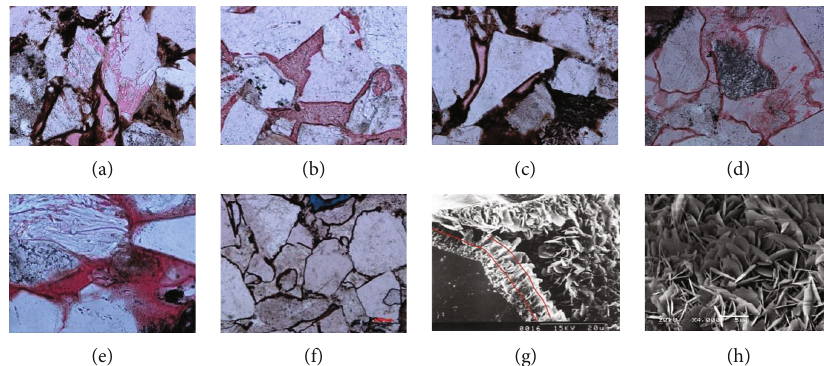
Figure 7: Micrograph of reservoir rock. (a) Shan138 well 2156.13m Chang 6 3 . The chlorite clay fi lm is composed of inner layer and outer layer. The outer crystal structure is complete, and the inner layer is denser (SEM observations × 1000). (b) Gao42 well 1759.56m Chang 6 3 coniferous autochlorite crystals on clay fi lm surfaces (SEM observations × 2000). (c) Shan139 well 2211.91m Chang 6 3 . The chlorite clay fi lm develops and is absent at the contact point of granule (injecting thin sections observations × 200). (c) Bai246 well 2340.72 m Chang 6 3 . The chlorite clay fi lm develops, intergranular pores fi lled with the iron calcite cement (injecting thin sections observations × 200). (e) Xi77 well 2115.16m Chang 6 3 chlorite clay fi lm is developed, intergranular pore is fi lled with aumonite cementation cement, and part of aumonite cementation cement is dissolved, resulting in intergranular pore (injecting thin sections observations × 200). (F) Bai168 well 2237.92m Chang 6 3 . The chlorite clay fi lm develops, and intergranular pores are cemented by late carbonate cement (injecting thin sections observations × 200). (g) Wu61 well, 2154.00m Chang 6 3 . The chlorite clay fi lm develops, and the secondary quartz of an intact crystal form can be seen in the intergranular pore (injecting thin sections observations × 200). (h) Zhuang 58 well, 2022.80m, and Chang 6 3 .